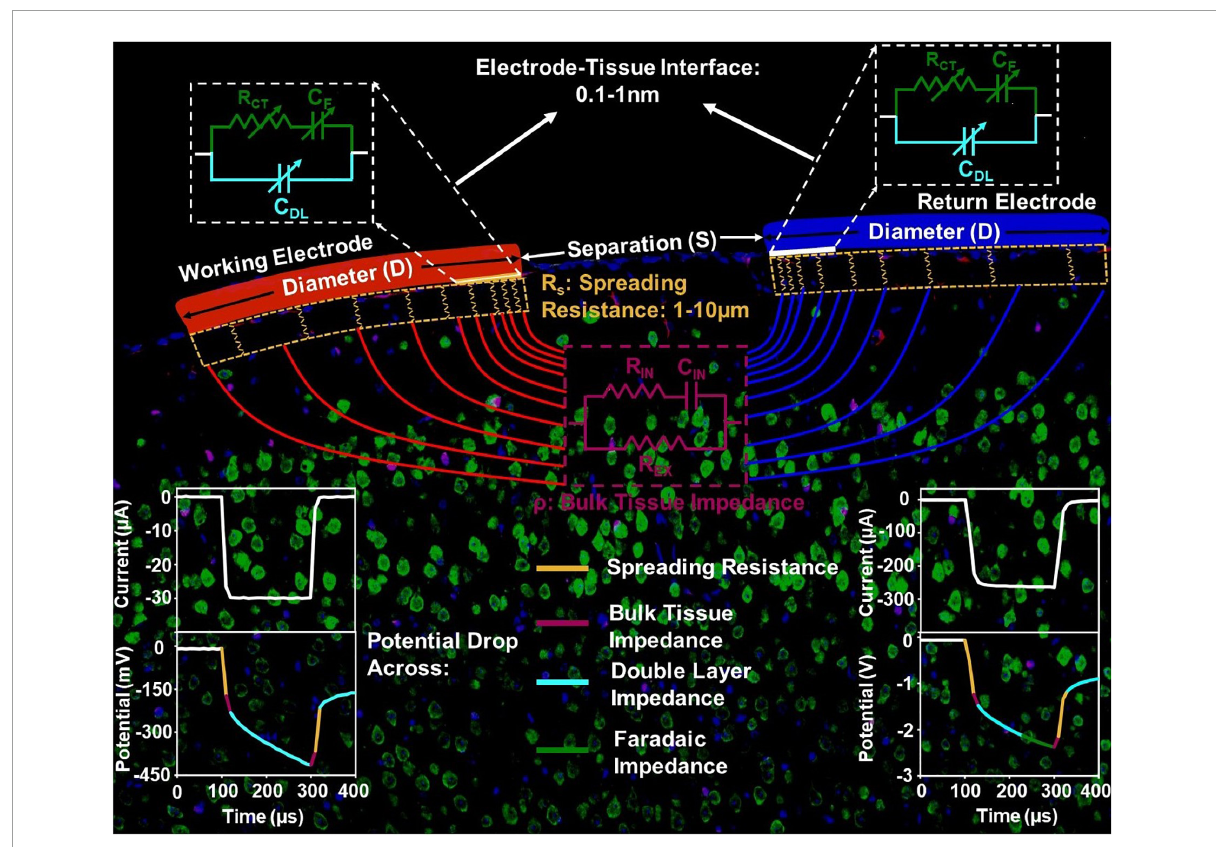
FIGURE1 The circuit model of the current injection mechanism in vivo , with the impedance elements corresponding to the electrode-tissue interface, spreading resistance and bulk tissue resistance spatially delineated.